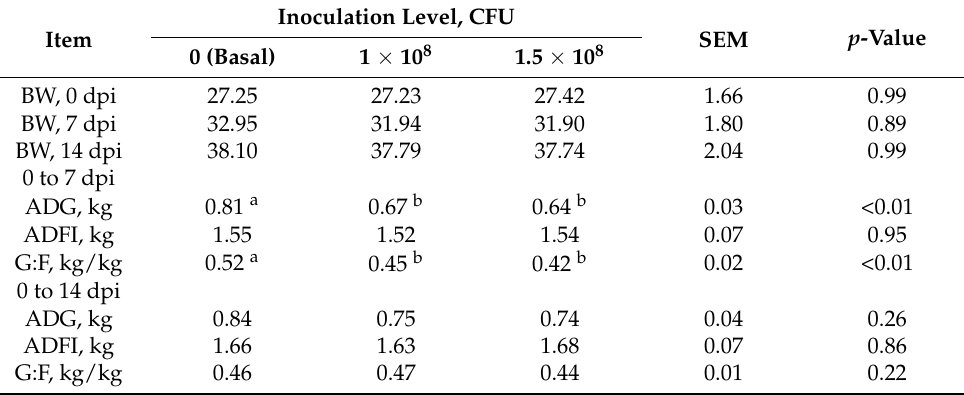
Table 1. Growth performance of growing pigs orally challenged or not with Salmonella